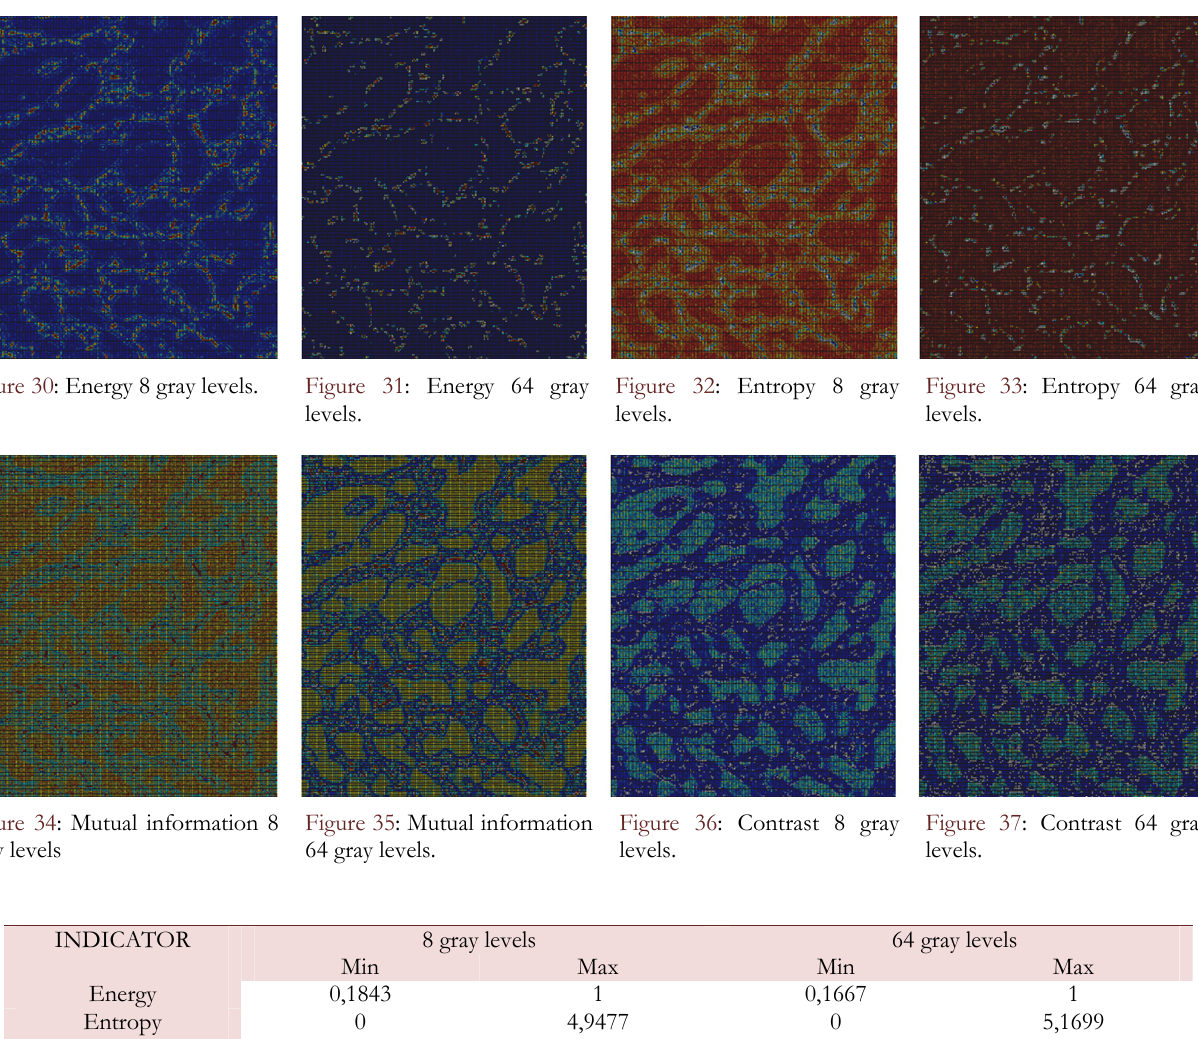
Figure 36: Contrast 8 gray levels.